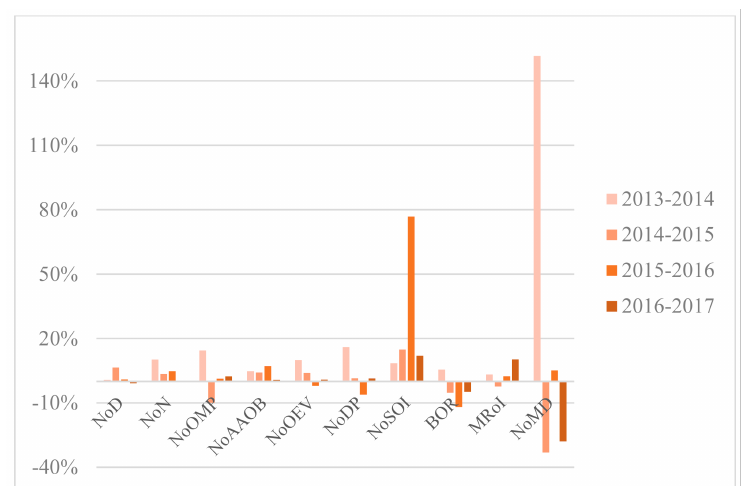
Figure 3. Annual growth rates of variables, PH.